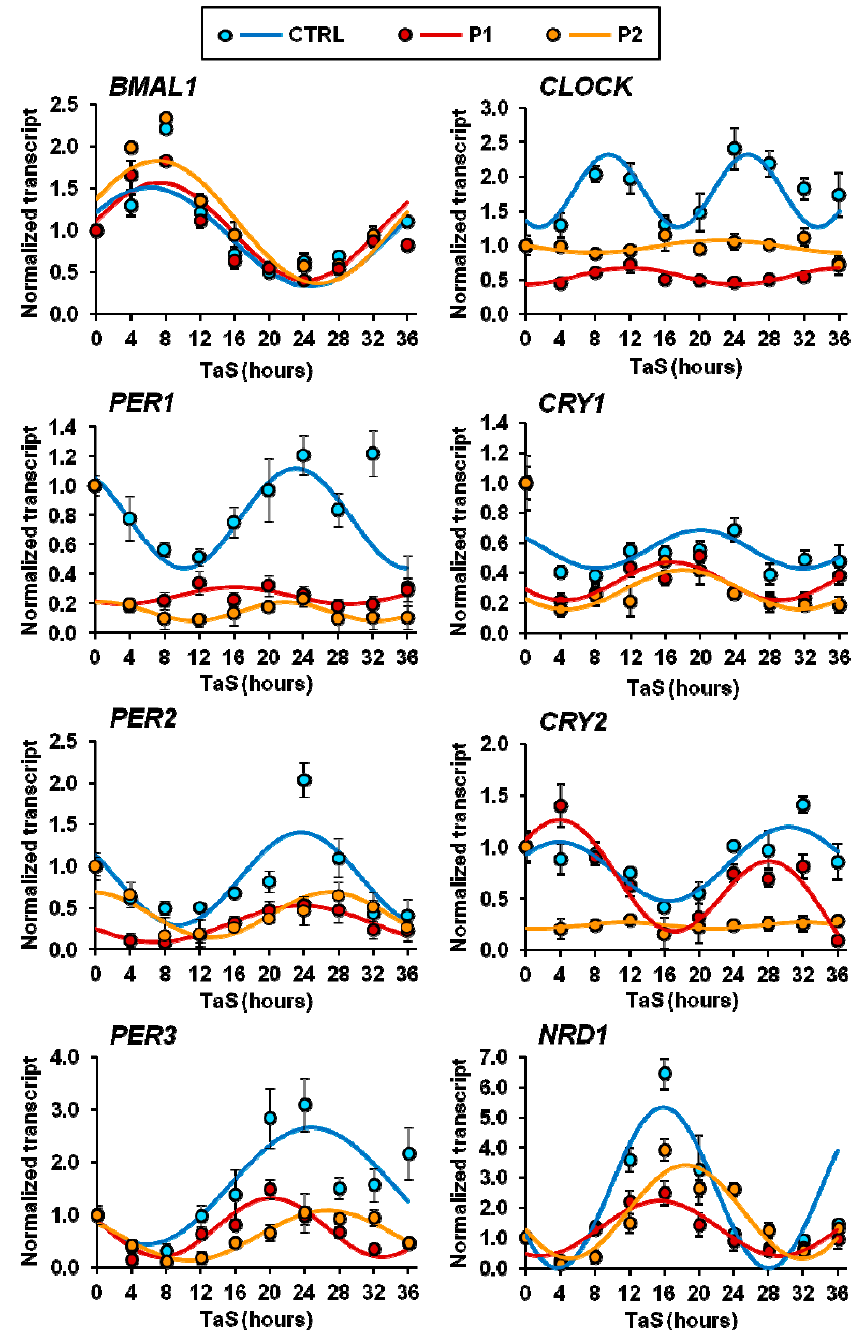
Figure 7. Transcription levels of core clock genes in serum-shocked synchronized normal (CTRL) and PD-derived (P1, P2) fibroblasts. mRNA levels of the indicated genes were assessed by qRT-PCR analysis and normalized to the housekeeping gene GAPDH . The time-points are expressed as fold-changes compared to time after synchronization (TaS) = 0 and best fit with the COSINOR function. The values shown are means ± SEM of two independent experiments performed in triplicate under each condition. See Materials and Methods for experimental